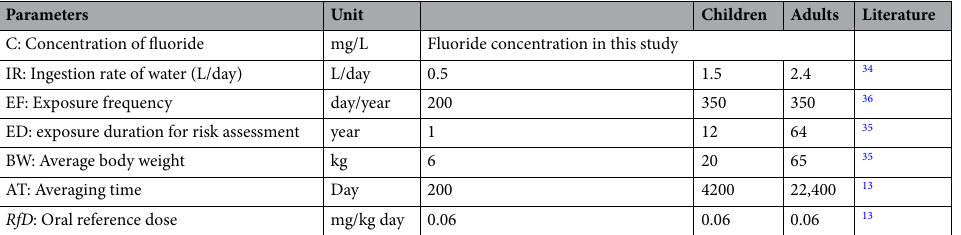
Table 1. Parameters employed for human health risk exposure assessment in groundwater.